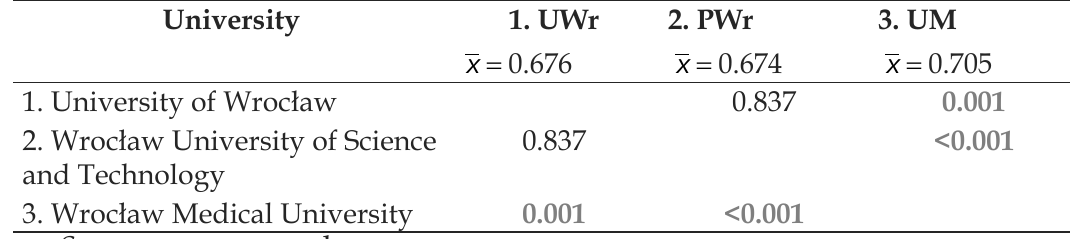
SPM “physical activity currently.” The result of multiple comparisons with the post-hoc test (signi (cid:192) cance levels of p-differences).